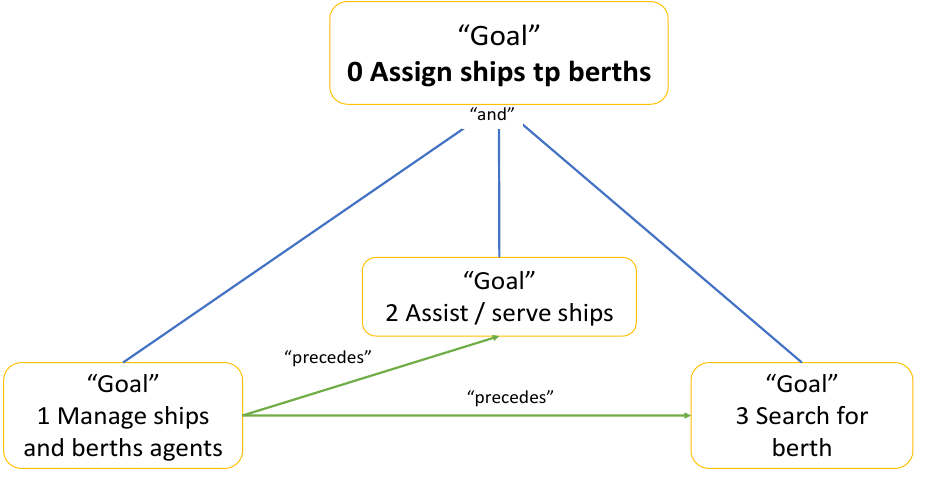
Figure 4. Goal model of O-MaSE.